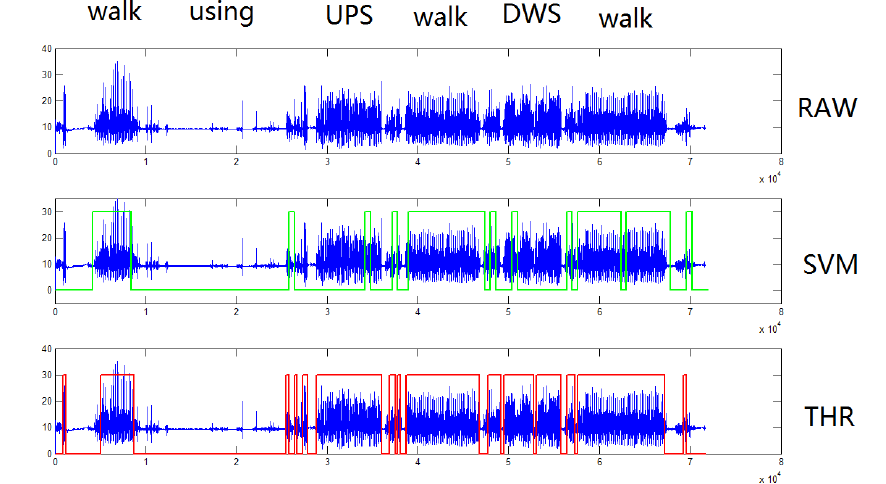
Figure 4. Example of walk detection in a real timeline.